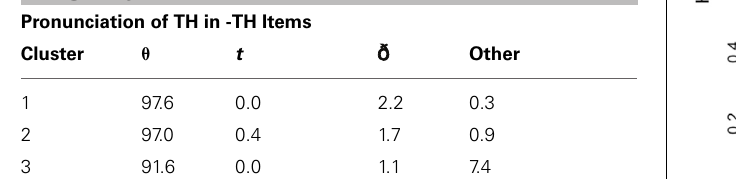
FIGURE 3 | Clustering results for the Pritchard et al. (2012) non-word reading data, using Ward’s method and including response data from the 45 subjects, DRC, and CDP ++